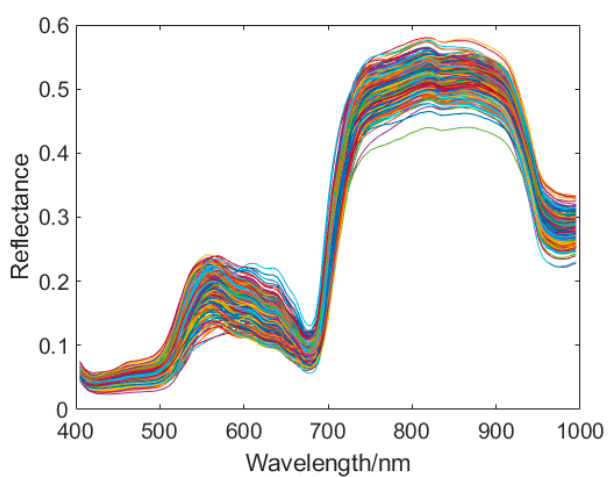
Figure 3. Original spectral reflectance curves of the plum samples. Table 3. Software and hardware environment configuration.